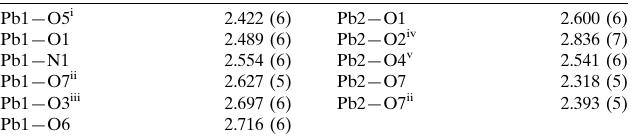
Selected bond lengths (A˚ ).